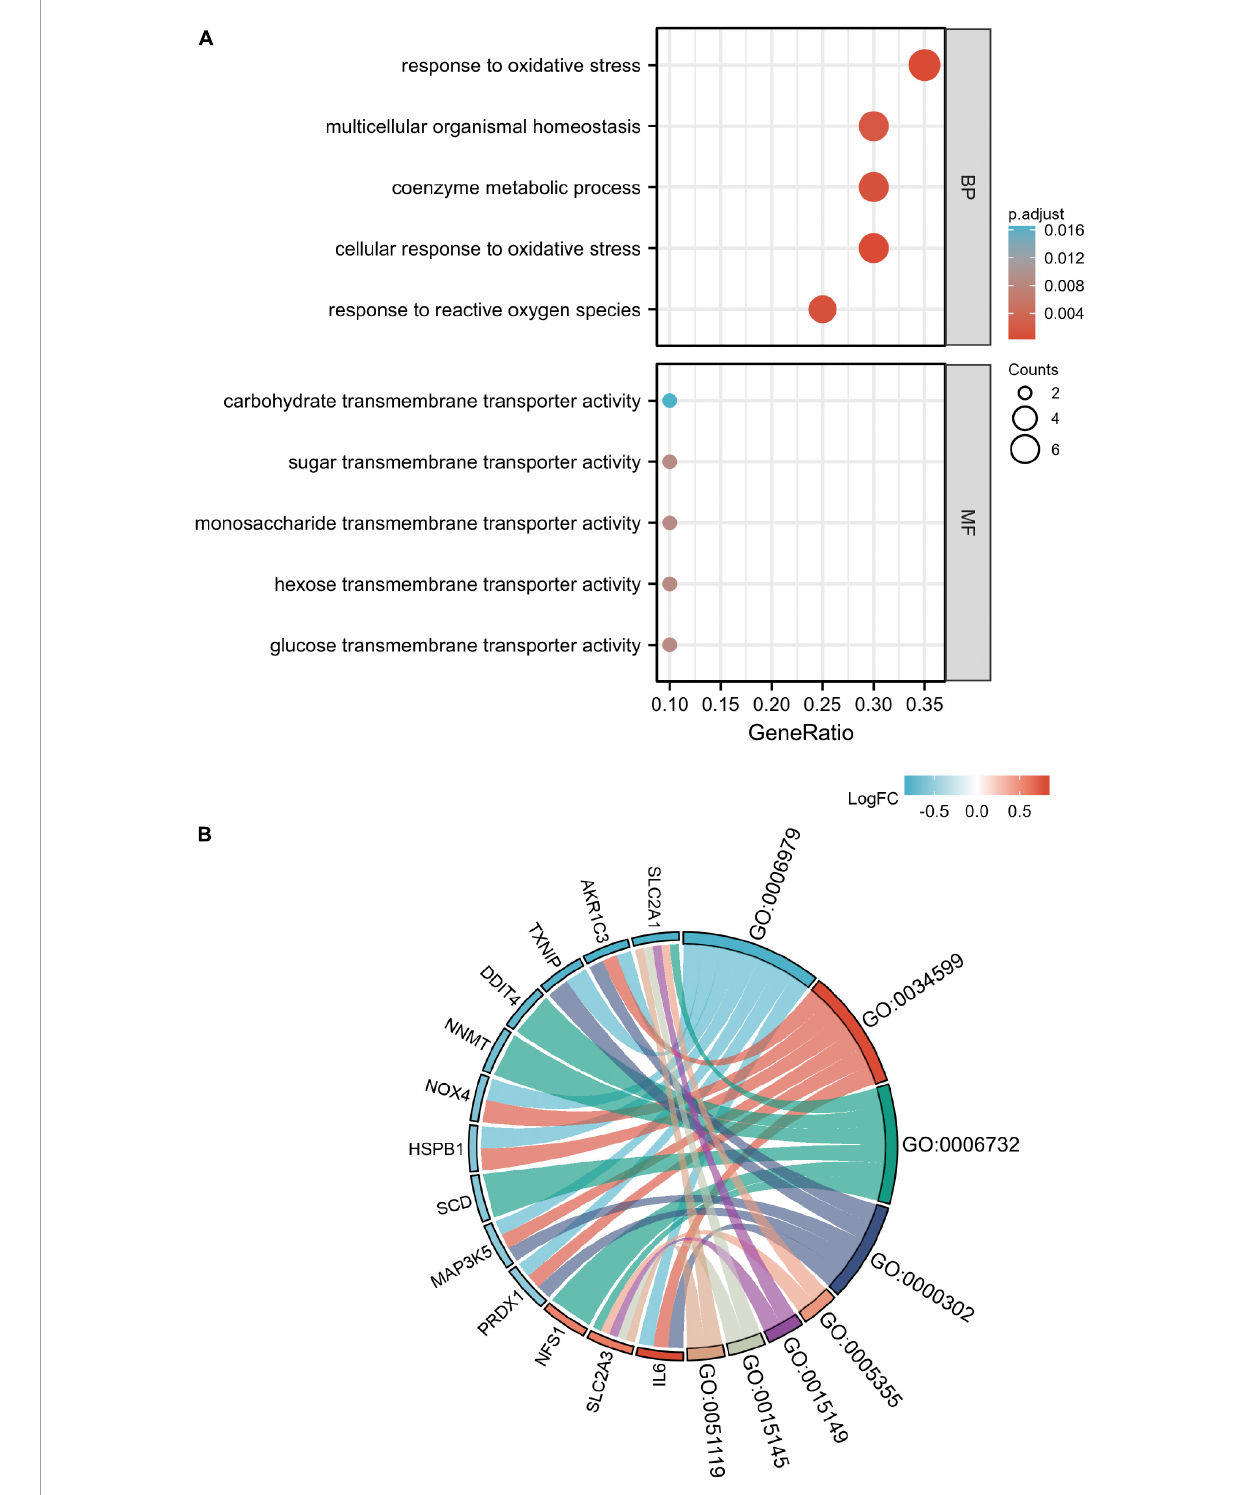
FIGURE5 Gene ontology (GO) enrichment analysis of 20 differentially expressed ferroptosis-related genes. Bubble diagram of GO enrichment term (A) and chord diagram of GO enrichment term (B) . Some candidate genes are not shown in chord diagram because the enrichment is too